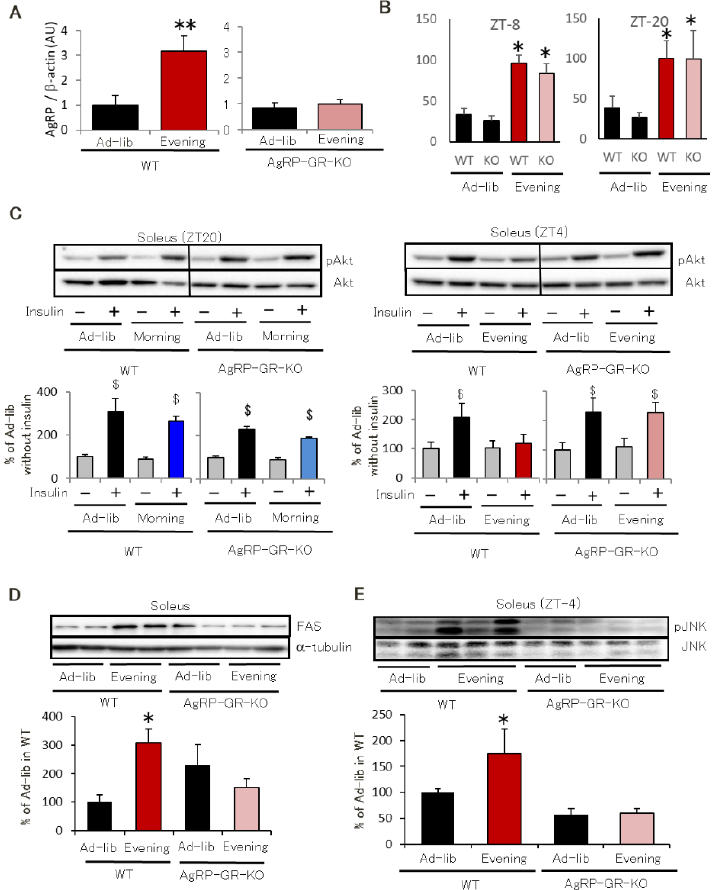
Figure 7. AgRP neuron-specific GR deficient mice does not show insulin resistance in skeletal muscle even in the Evening feeding schedule with decrease in AgRP expression. ( A ) Hypothalamic AgRP expression in WT and AgRP-GR-KO mice ( n = 6). ( B ) Plasma glucocorticoid level in WT and AgRP-GR-KO mice ( n = 6). ( C ) Insulin-induced Akt phosphorylation in the soleus in WT and AgRP-GR-KO mice ( n = 3 – 5). ( D ) FAS expression in the soleus in WT and AgRP-GR-KO mice in the Ad-lib and Evening groups ( n = 3 – 5). ( E ) JNK phosphorylation in soleus of WT or AgRP-GR-KO mice ( n = 3 – 4). Data are presented as mean ± standard error. * p < 0.05, ** p < 0.01 vs. Ad-lib group. $ p < 0.05 vs. Akt phosphorylation of each group without insulin.